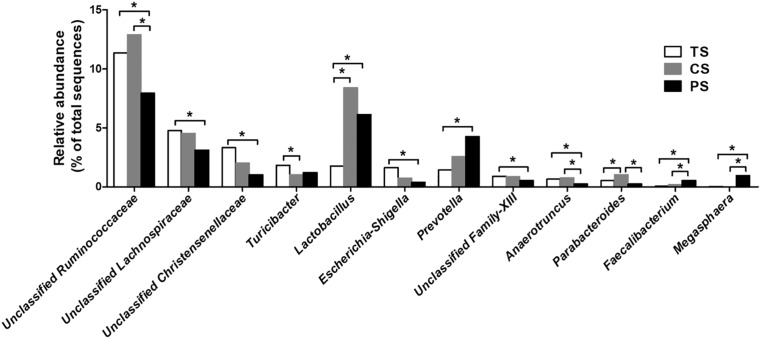
Significantly changed bacteria genera by different starch source diet treatment. The values were expressed as the medians (n = 8). Statistical differences were calculated by Kruskal–Wallis test: ∗FDR-adjusted P-value < 0.05. TS, tapioca starch; CS, corn starch; PS, pea starch.